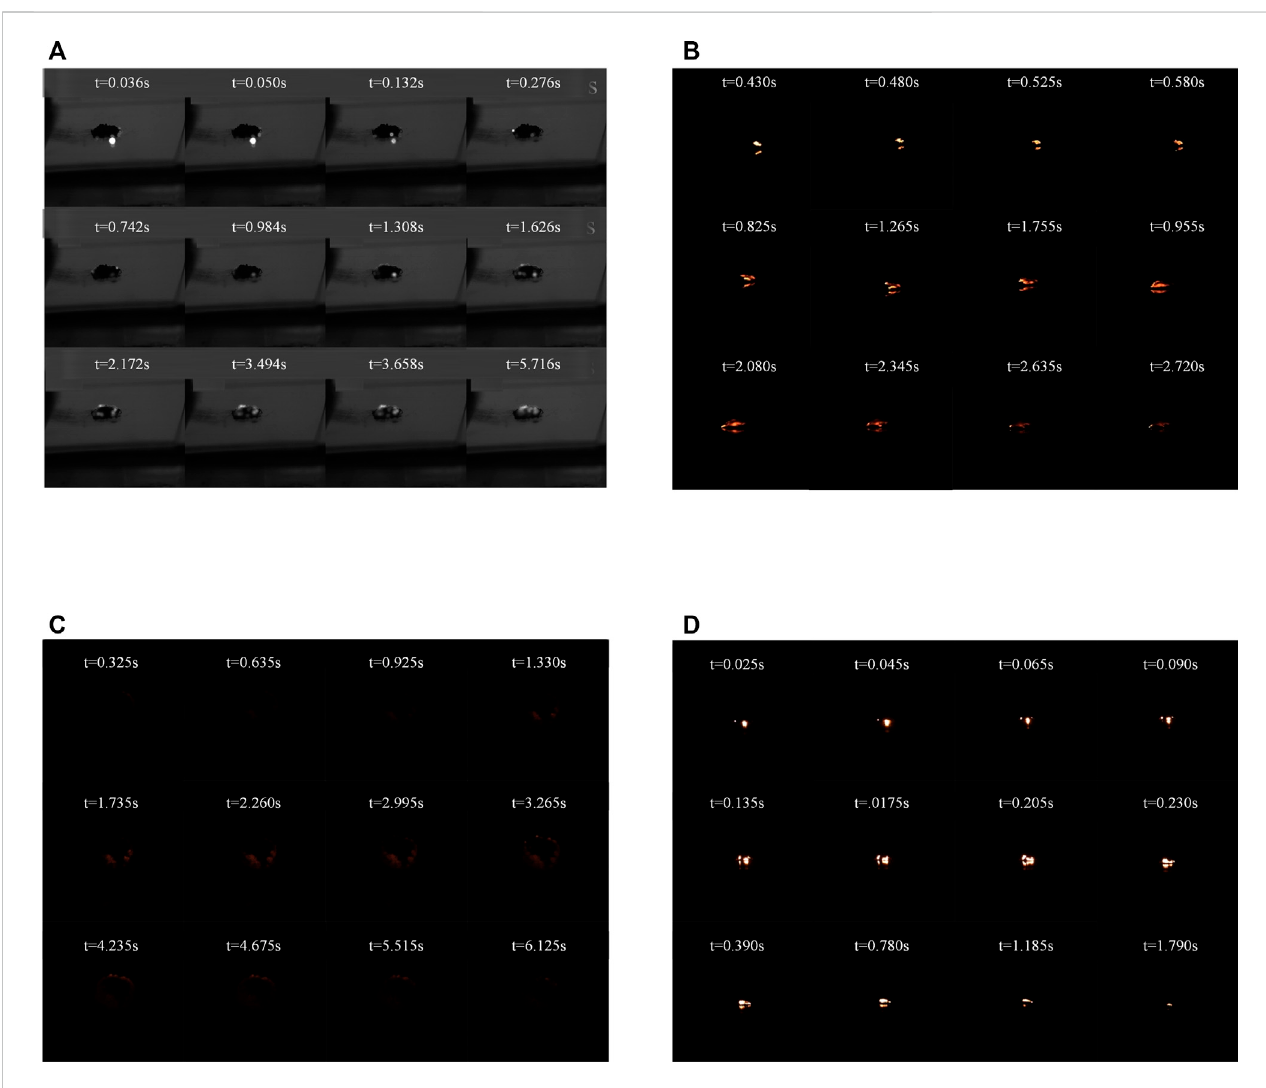
FIGURE 2 The images of the ignition and combustion process (A) pure iron nanoparticles, (B) pure aluminum nanoparticles, (C) 10 wt% (Fe/TiO 2 ), (D) 10 wt% (Al/ TiO 2